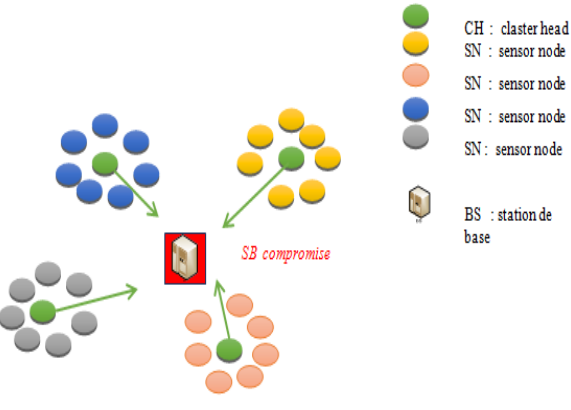
Figure 3. . Scenario with a single BS (BS compromised)